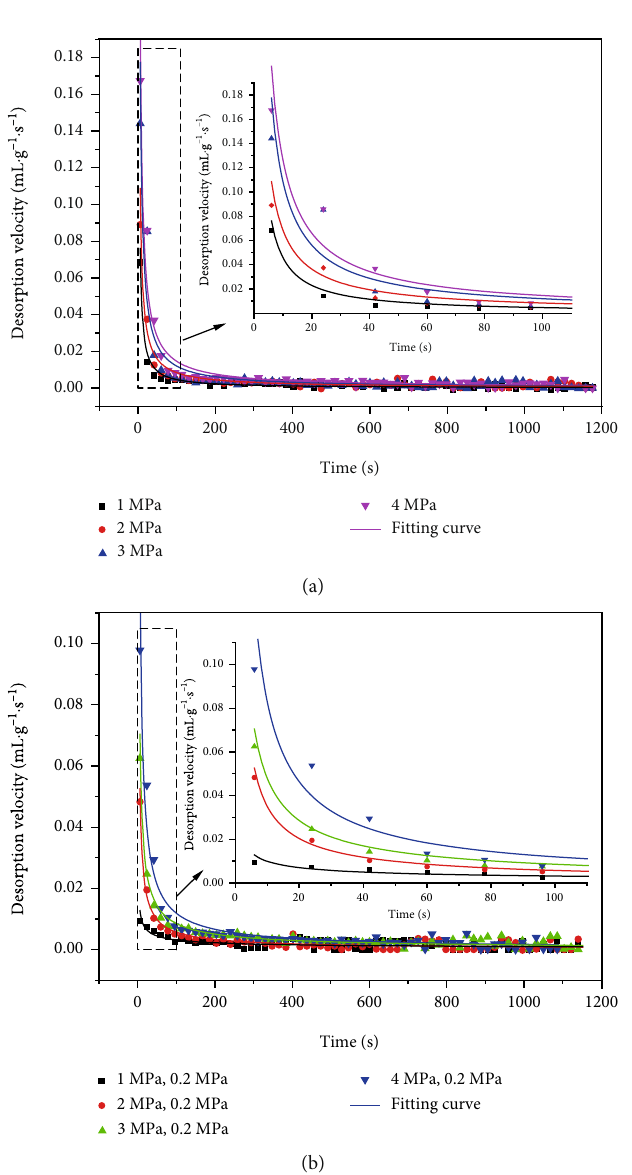
Figure 3: Relationship between desorption velocity and time: (a) under atmospheric pressure and (b) under a positive pressure of